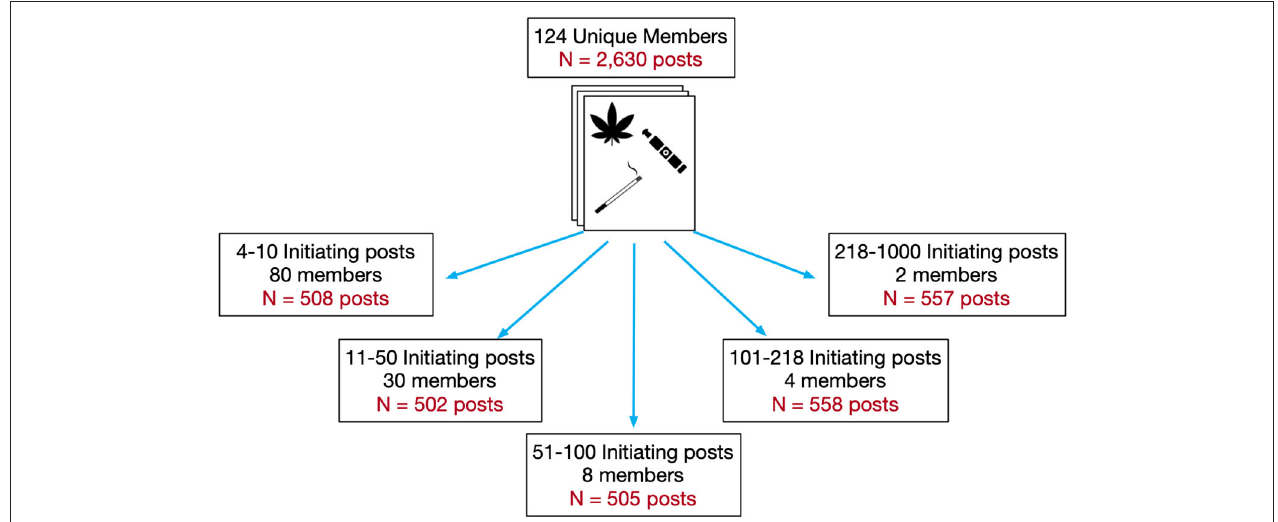
FIGURE 3 | Member and post selection for manual